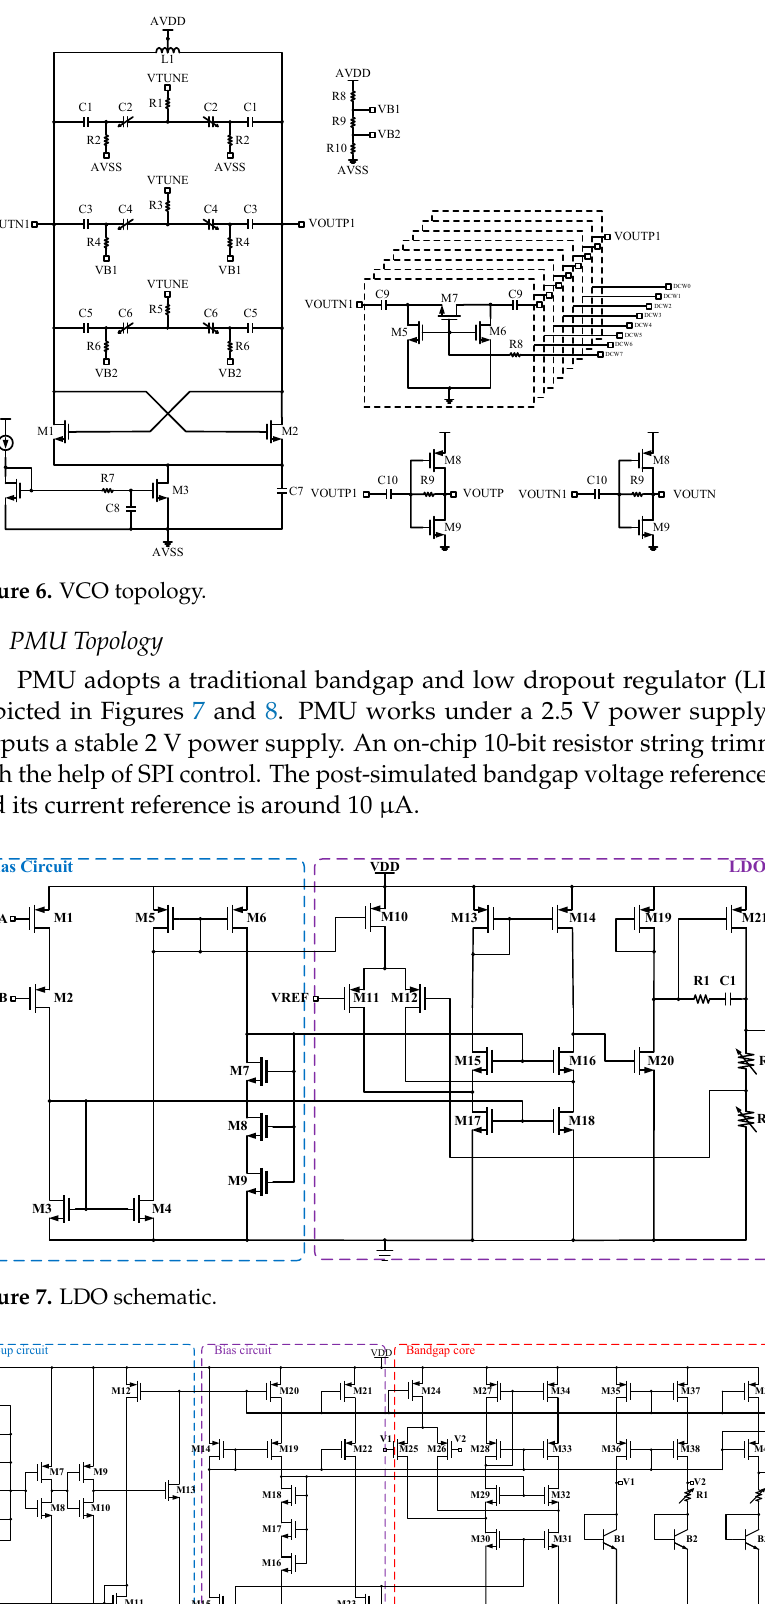
Figure 8. Bandgap schematic.